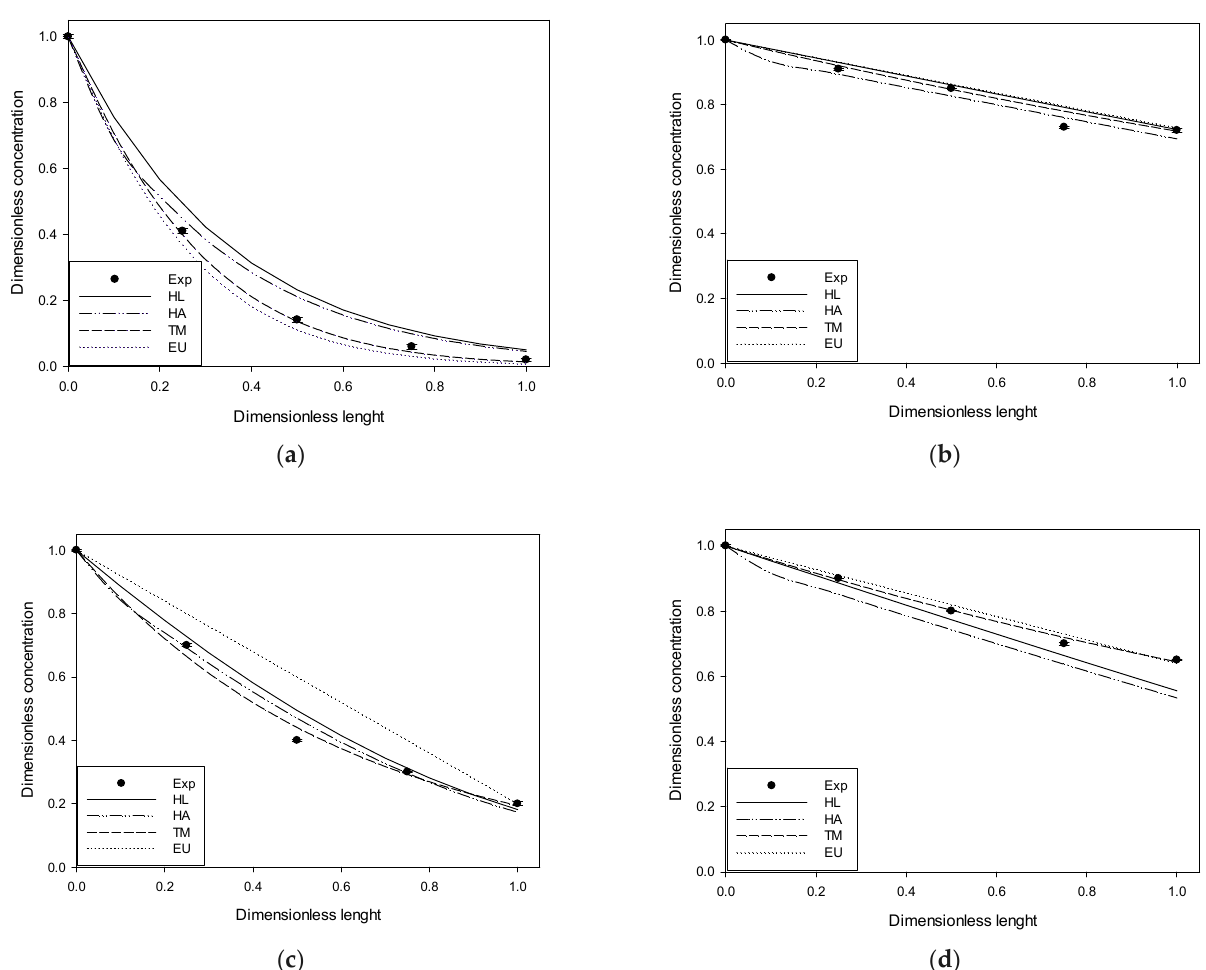
Figure 3. Nondimensional simulation results compared to experimental data with 10 ppm of input.